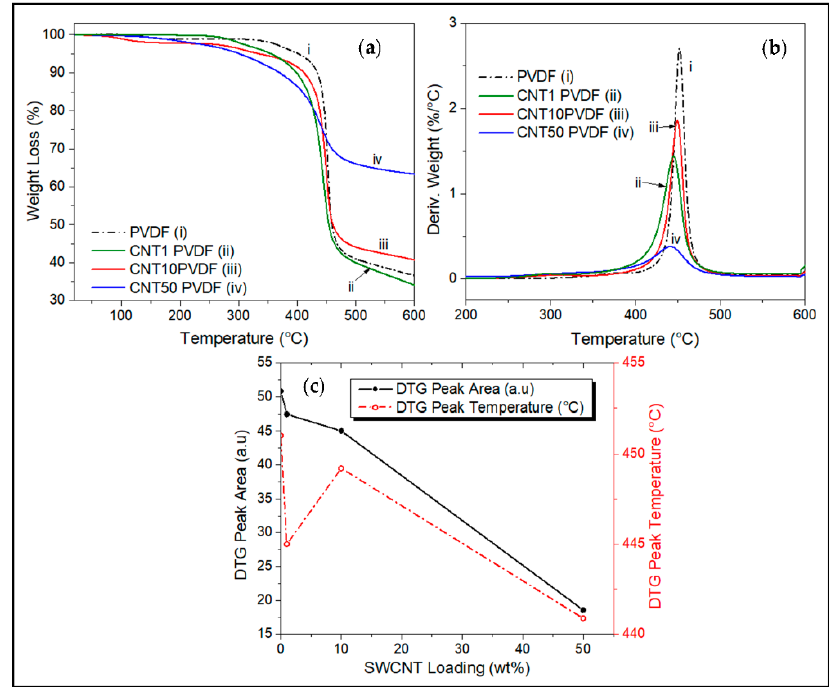
Figure 6. ( a ) TGA thermogram comparisons of the effect of CNT wt.% loadings on decomposition of PVDF, with their respective ( b ) derivative weight curves, TGA test was carried out from room temperature to 600 ◦ C under N 2 atmosphere. ( c ) effect of CNT loading on the DTG peak area and peak temperature.